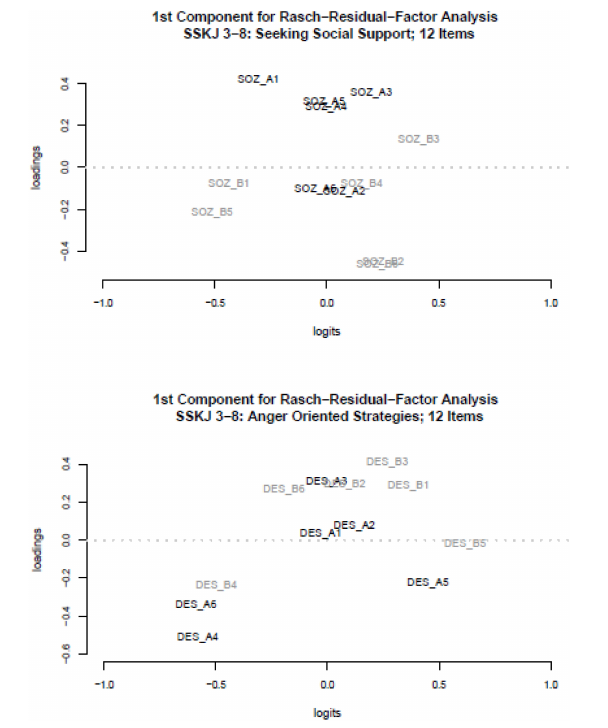
FIGURE 2 | Rasch-Residual-Factor Analysis: Loadings on the first component ( y -axis) and item difficulties in Logits ( x -axis) for scale SOZ (top panel) and scale DES (bottom panel) ; A = social situation (arguing with a friend), B = academic situation (problems with homework).